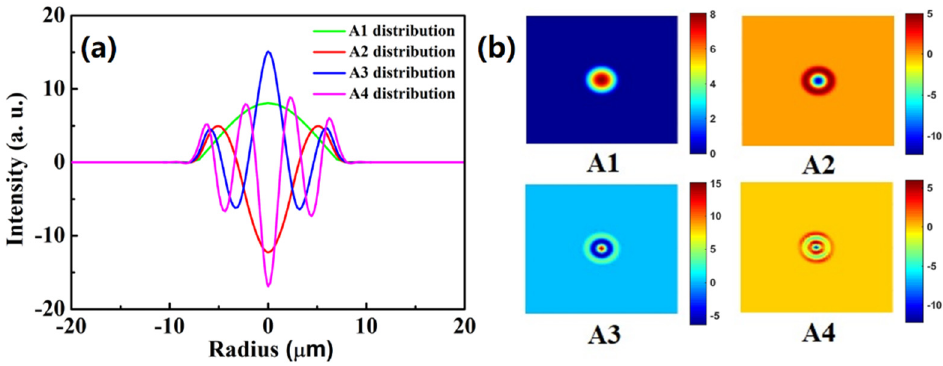
Figure 3. ( a ) Two-dimensional (2D) mode profiles and ( b ) field patterns of four acoustic modes. When several acoustic modes are excited in the fiber simultaneously, each acoustic mode is responsible for a spectral feature in the Brillouin gain spectrum (BGS). The BGS corresponding to the i th acoustic mode can be expressed as [12]